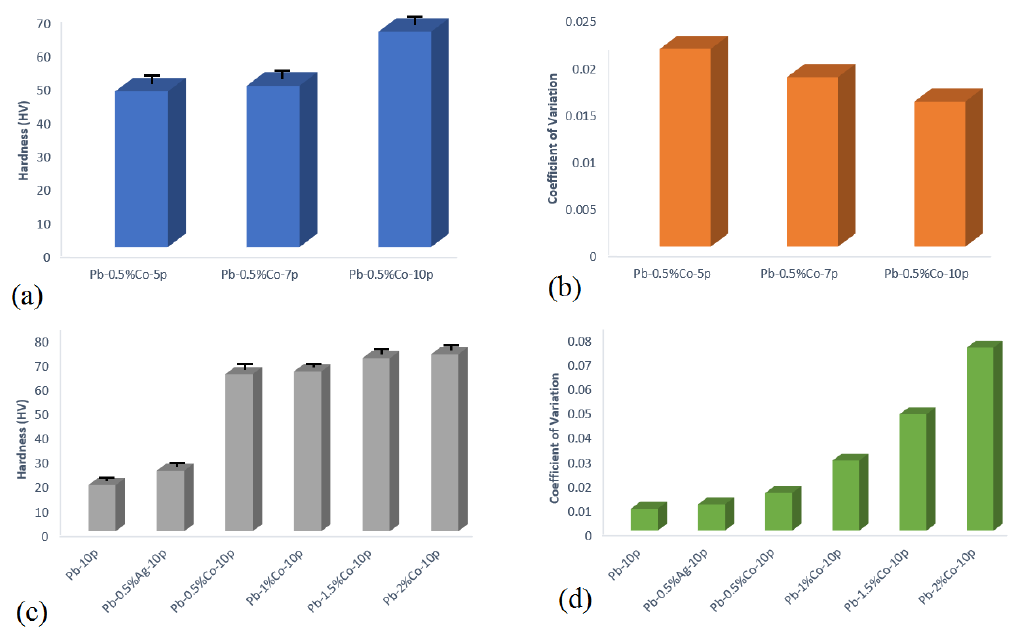
Figure 3. ( a , c ) Hardness and ( b , d ) coefficient of variation of different samples.